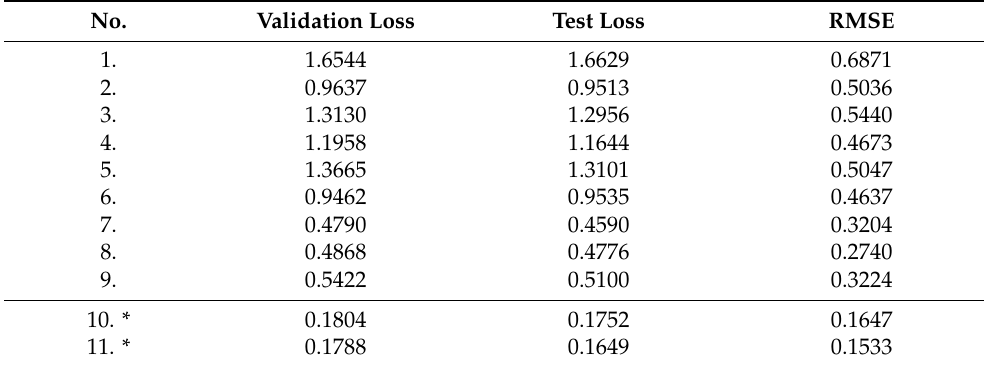
Table 2. Network losses and RMSE for Franka robot during